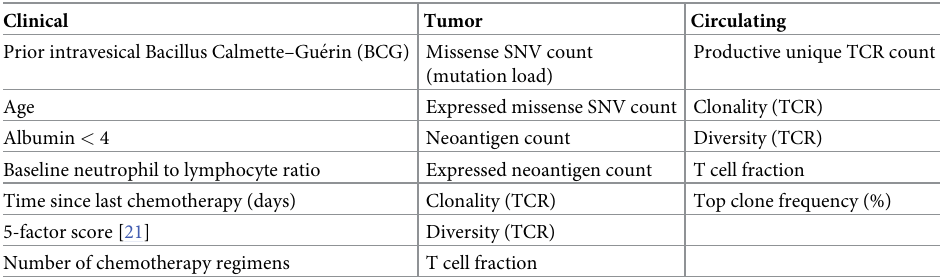
Table 1. Patient attributes collected prior to treatment and processed as learning pipeline